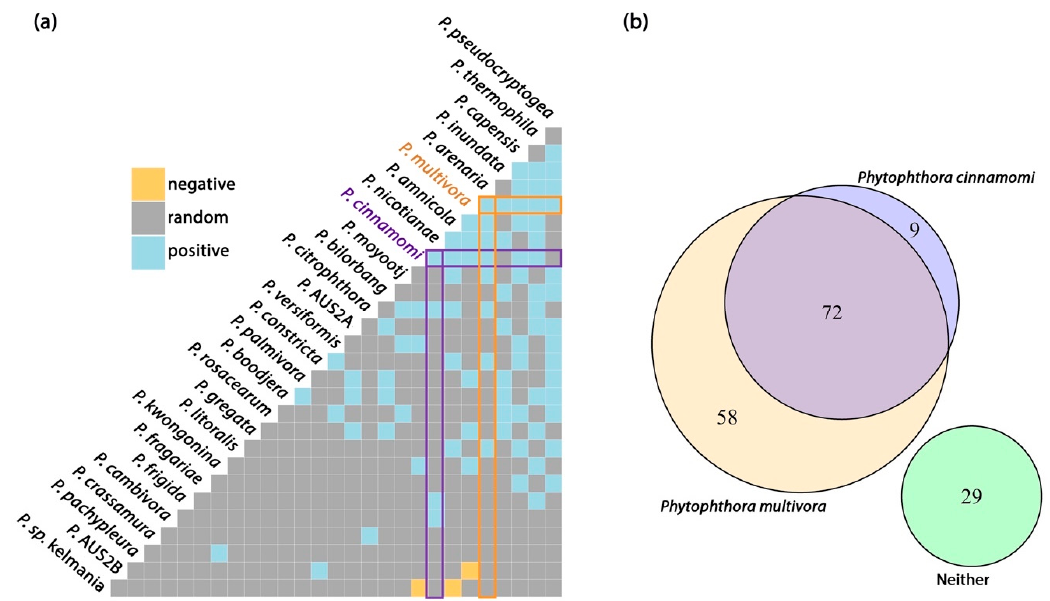
Figure 4. ( a ) Pairwise co-occurrence matrix for a subset of Phytophthora species that exceeded a minimum threshold of expected co-occurrence ( > 1 site). Orange and blue tiles correspond to species pairs that were less or more likey to co-occur than predicted by a null model. ( b ) Venn diagram of detections from 168 sampling sites showing the relationship between the two main invasive species, Phytophthora cinnamomi and P. multivora.